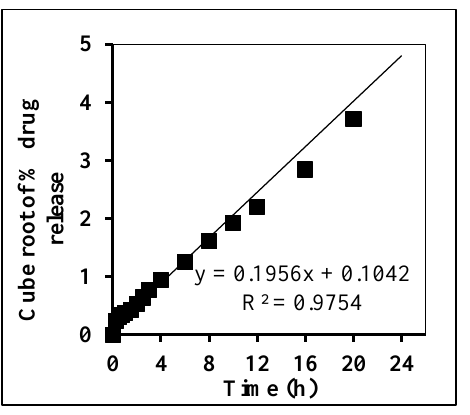
Figure 2. The release kinetics of optimized, β - ST - loaded cubosomal formulation (FC4).